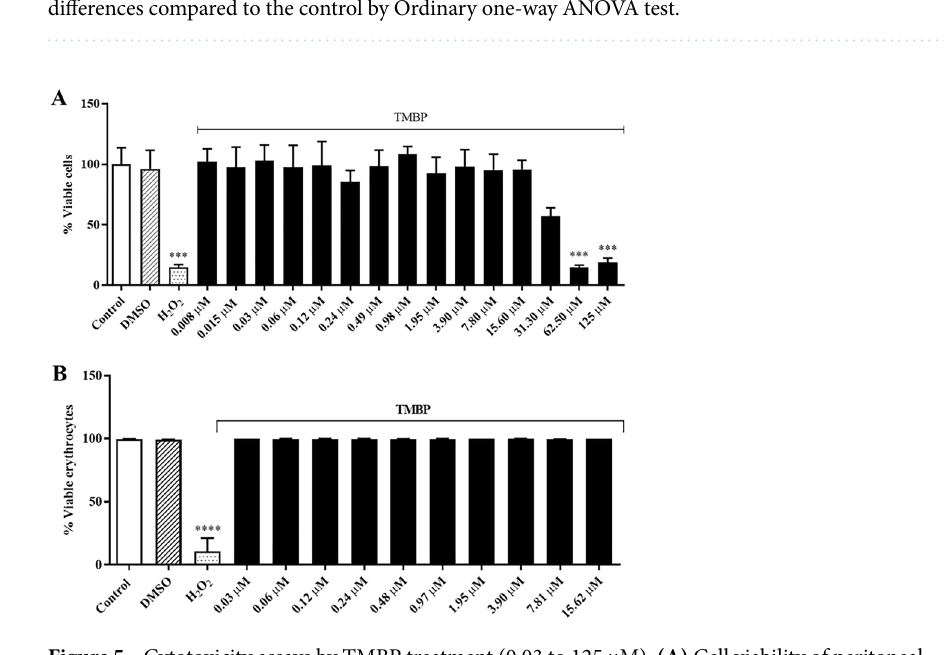
Figure 5. Cytotoxicity assays by TMBP treatment (0.03 to 125 μM). (A) Cell viability of peritoneal macrophages from BALB/c mice. (B) Cell viability of sheep erythrocytes. Control (non-treated parasites), H 2 O 2 or H 2 O positive control, and DMSO as a compound diluent (0.015%). Data represents the mean ± SEM of three independent experiments performed in duplicate. ***( p ≤ 0.001) and ****( p ≤ 0.0001) are the statistical differences compared to the control by the Ordinary one-way ANOVA